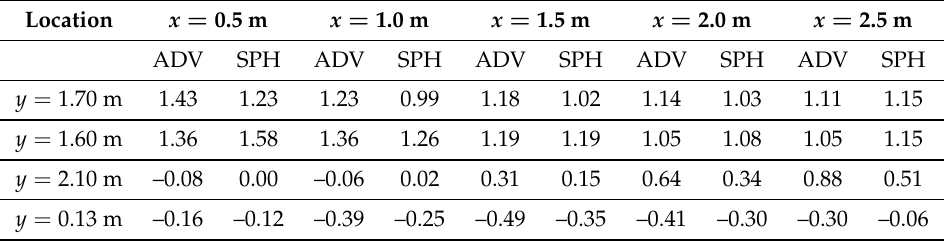
Figure 8. Measured (Bombaˇc et al., 2015) and calculated u and v velocity profiles. Table 1. Measured (ADV) and calculated (SPH) average values of u in m/s for the calibrated model.